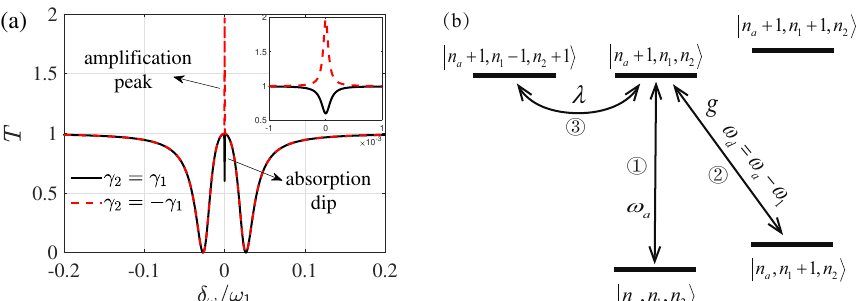
Figure 7. ( a ) The transmission rate T of the output field as a function of the normalized frequency δ ω / ω 1 , in which λ = 0.01 λ 0 , η = 1/2, κ = 0.1 κ 0 , and P = 2 mW. ( b ) A schematic illustration of energy level of the three-mode system, where n a , n 1 , and n 2 represent the numbers of the photon and phonons of NR 1 and NR 2 , respectively. The other parameters are the same as given in Figure